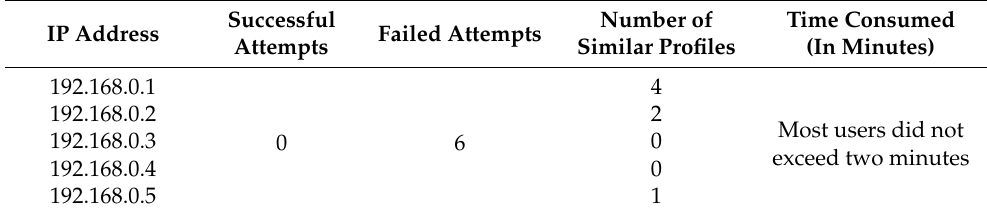
Table 3. Details of participants in the pilot